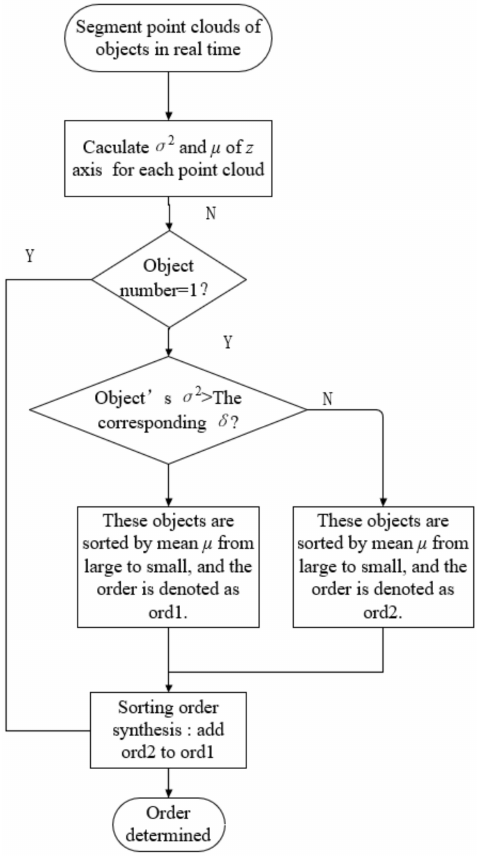
Figure 16. The sorting sequence reasoning algorithm